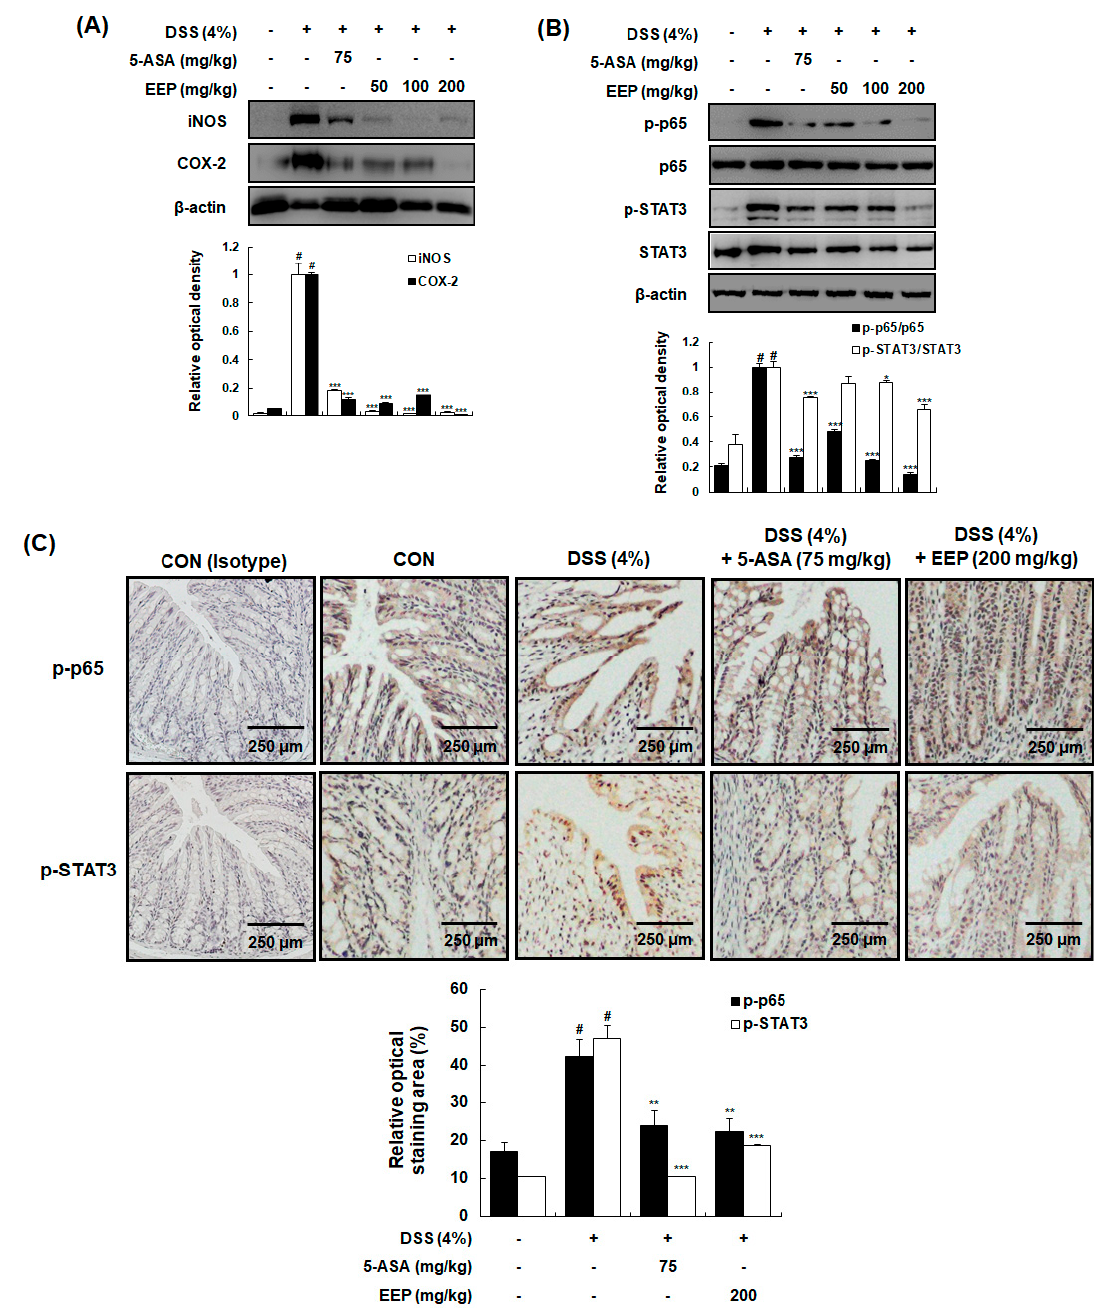
Figure 5. Effects of EEP on expression of iNOS and COX-2 and activation of NF- κ B and STAT3 in DSS-induced colitis mice. ( A , B ) Colonic tissues were obtained after 9 days of DSS treatment and whole proteins were prepared for Western blotting to detect protein expression levels of iNOS, COX-2, p-p65, p65, p-STAT3, and STAT3. β -Actin was used as an internal control. ( C ) Representative colonic sections from mice were immunostained for p-p65 and p-STAT3. The normal rabbit IgG antibody and the normal mouse IgG 2b antibody were used as isotype control for p-p65 and p-STAT3, respectively. Values are presented as means ± SDs ( n = 10). # p < 0.05 compared with vehicle-treated control group, and * p < 0.05, ** p < 0.01, *** p < 0.001 compared with DSS only-treated group.